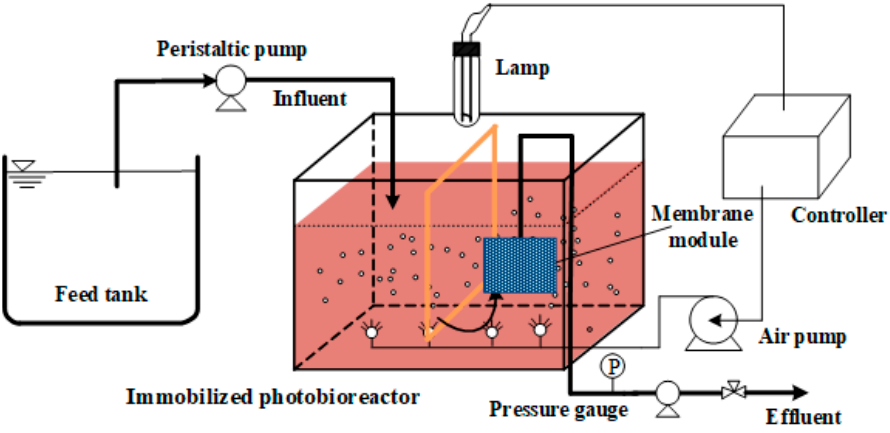
Figure 1. Schematic diagram of the experimental process.